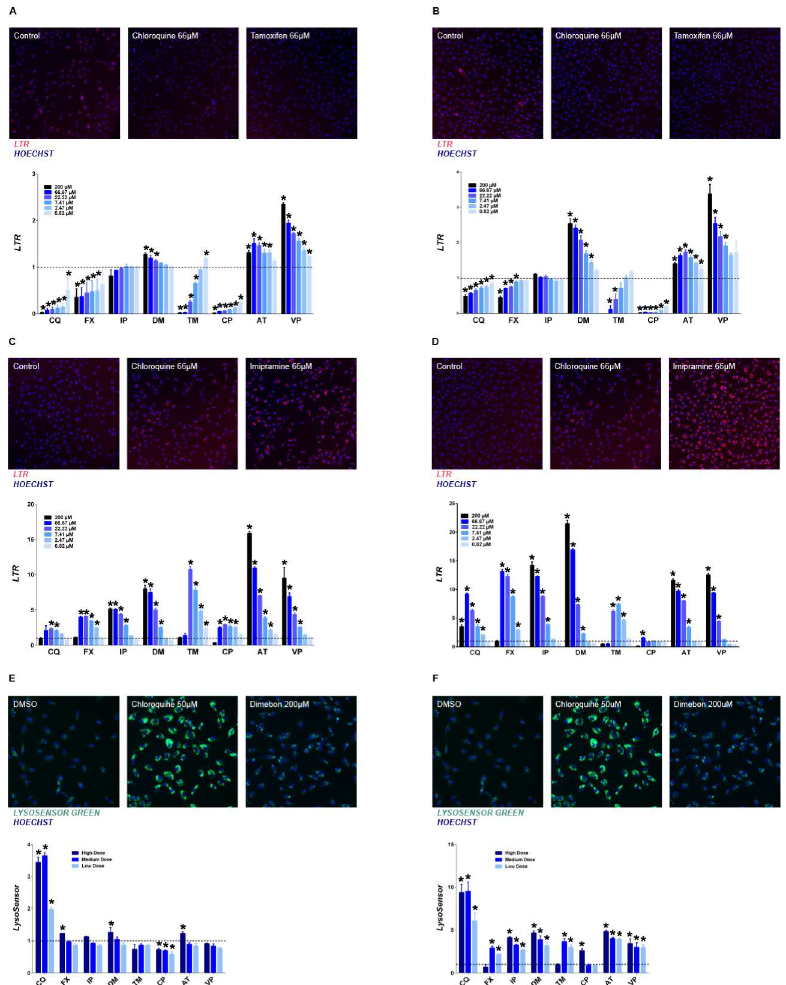
Fig 1. Effectof lysosomotropic drugs on lysosome volume and pH. Representative imagesfor LTR after 30 mins (A), 1 hr (B), 4 hrs (C) or 24 hrs (D) andlysoSensor greenafter 4 hrs (E) or 24 hrs (F) of drugtreatment. Quantificationdata in eachpanelis presented as fold changeof the total signalintensity comparedto control (mean ± SD), * p (cid:20) 0.05. Tested drugsincludechloroquine (CQ), fluoxetine(FX), imipramine(IP), dimebon (DM), tamoxifen (TM), chloropromazine(CP), amitriptyline (AT), andverapamil (VP).